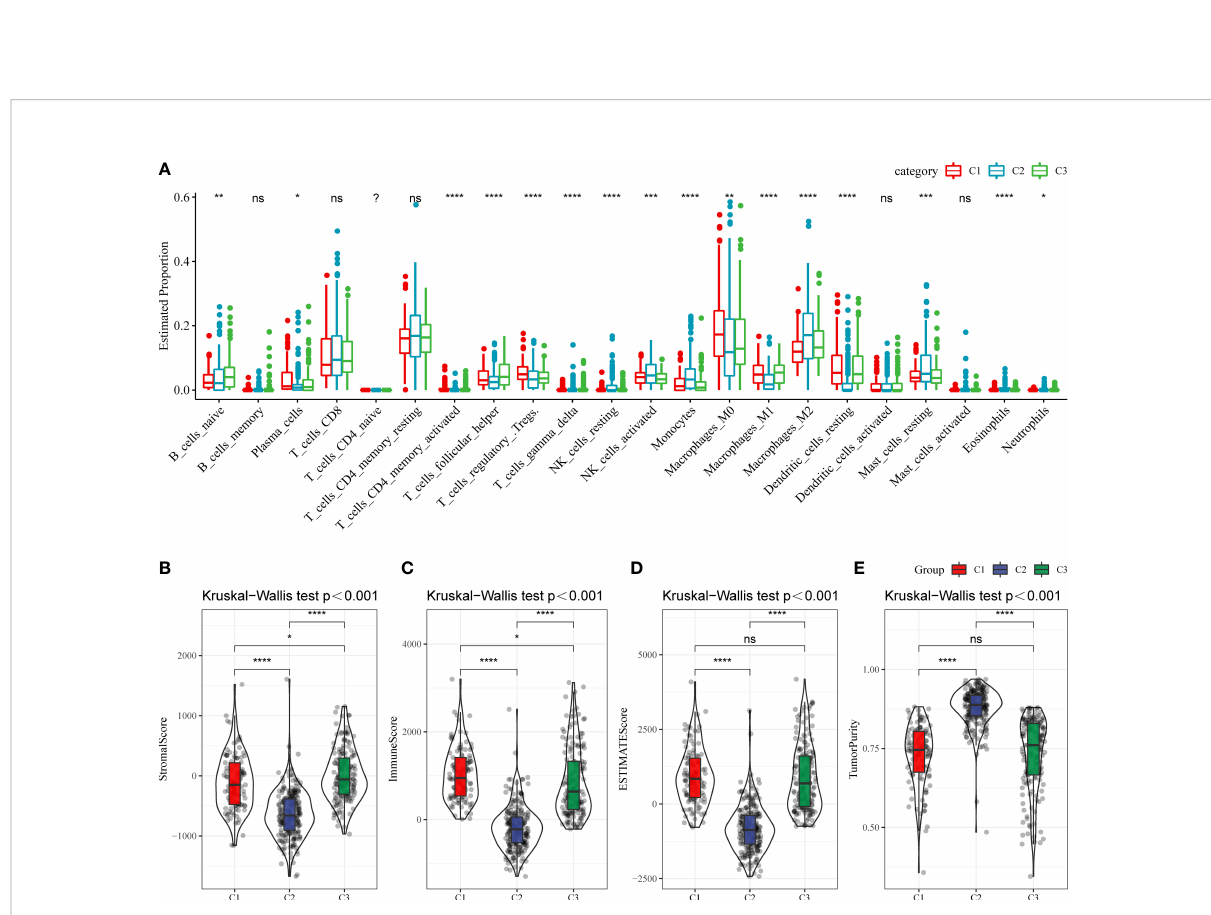
FIGURE 7 (A) The in fi ltration degree of immune cells in three molecular subtypes. (B – E) The proportion of immune cells in three molecular subtypes. ns, Not statistically signi fi cant; *p < 0.05; **p < 0.01; ***p < 0.001; and ****p < 0.0001.